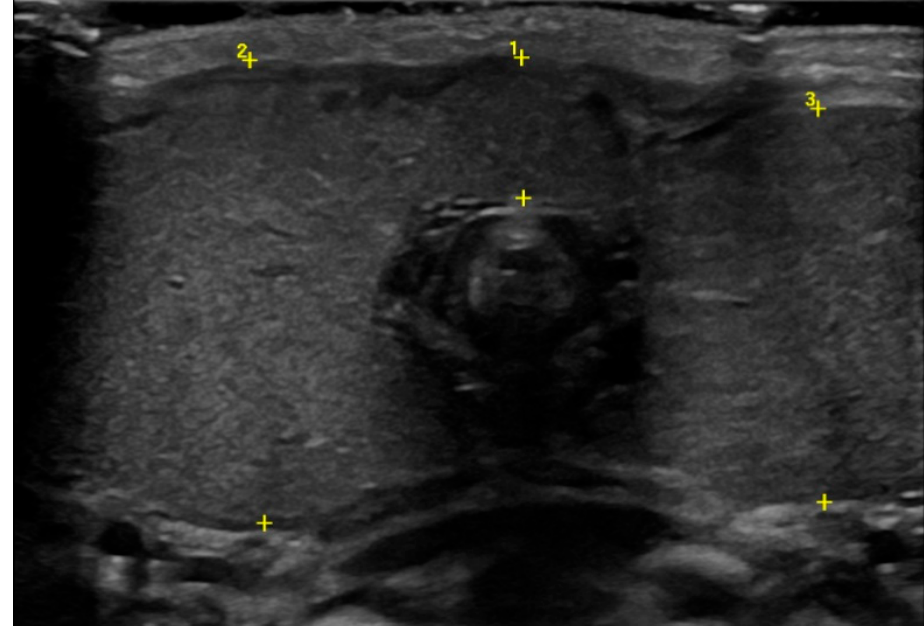
Figure 2. Thyroid ultrasound at birth in which the enlargement of the gland was detected (cursor 1 isthmus, 0.8 cm; cursor 2 antero–posterior diameter of the right lobe, 2.5 cm; cursor 3 antero–posterior diameter of the left lobe, 2.2 cm).